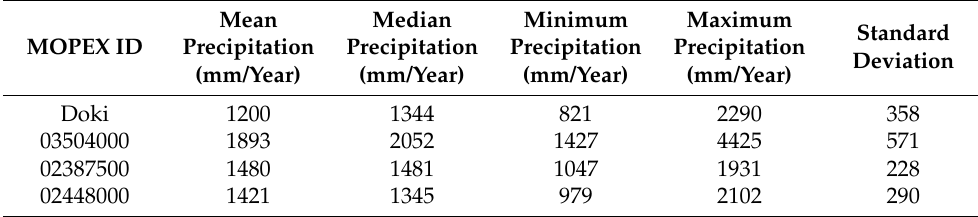
Table 2. Descriptive statistics of studied